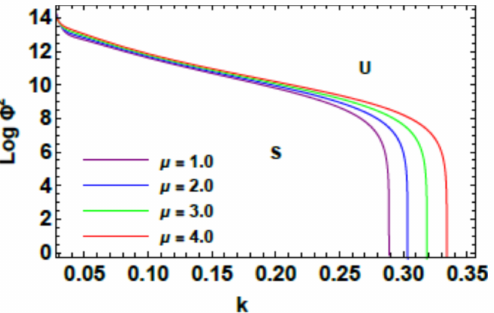
Figure 4. Plots of the stability bound for µ for different values the parameter k versus Log Φ 2